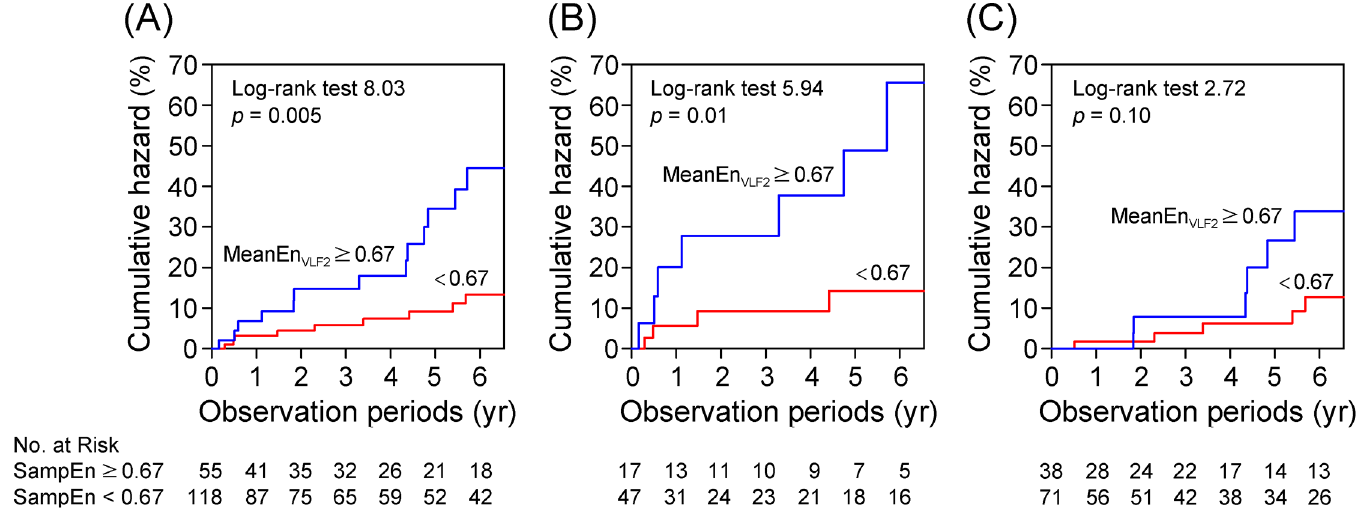
S1 Table. Multiple regression analyses of the MeanEn_VLF2. R 2 = 0.28. En: sampling entropy, VLF2: very-low frequency (90 – 300 s) power, TIA: transient ischemic attack,